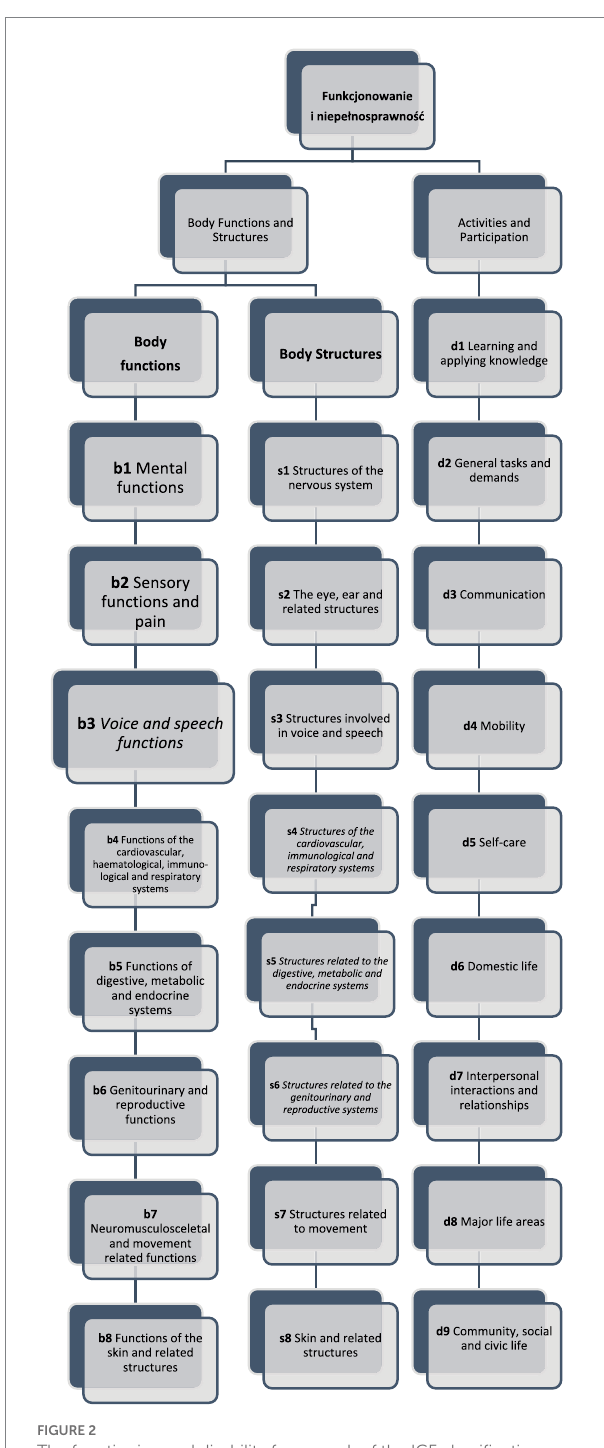
FIGURE 2 The functioning and disability framework of the ICF